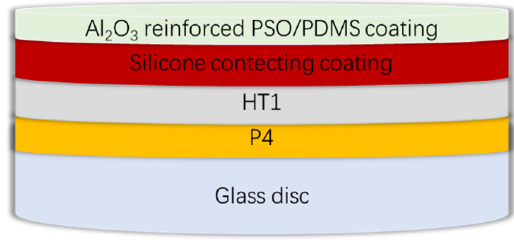
Figure 3. Schematic diagram of composite coatings.